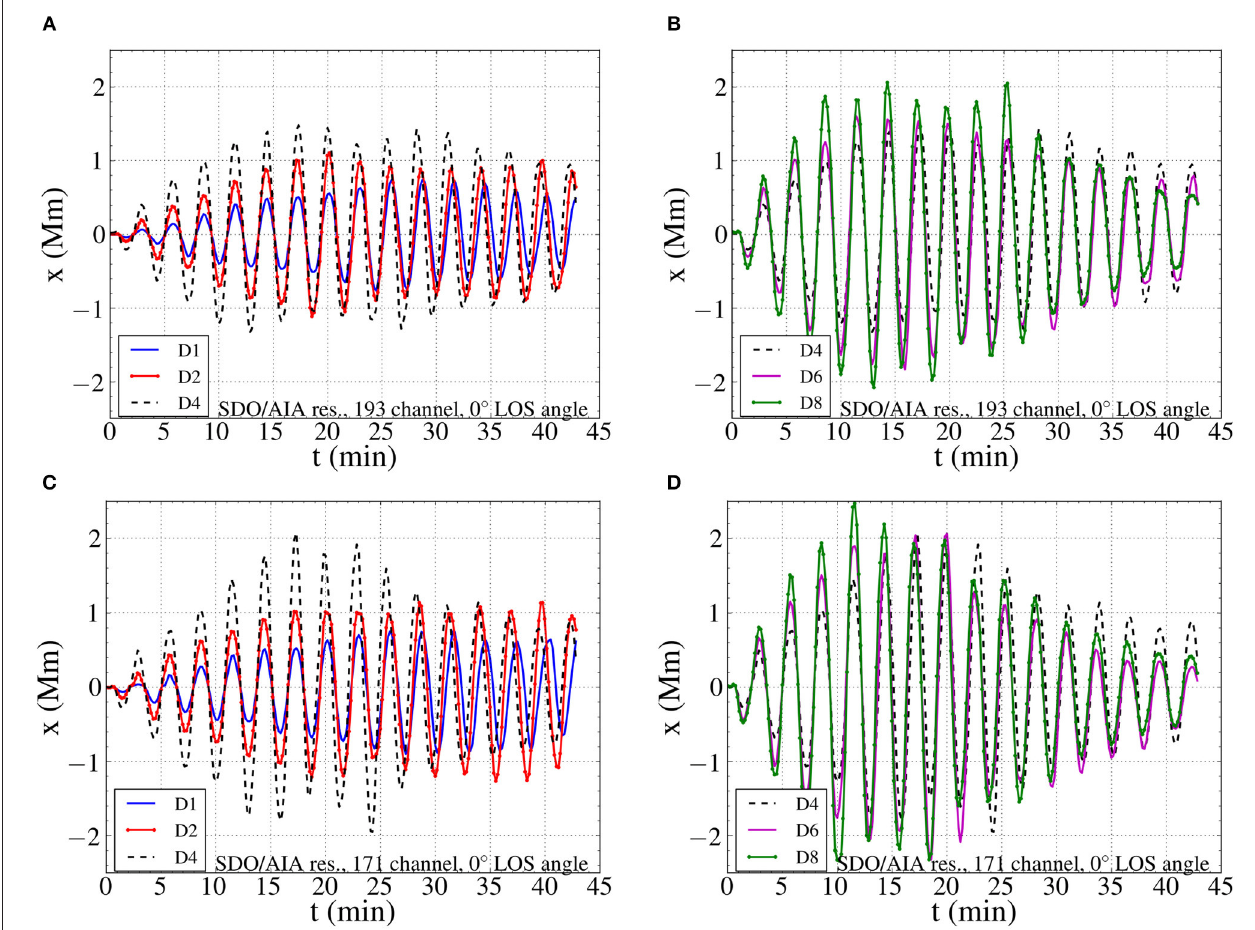
FIGURE 4 | Time distance maps of the oscillation amplitude for the five models. The apex displacements were obtained by tracking the loop edge in synthetic emission images of the Fe XII 193 Åline for (A,B) and of the Fe IX 171 Åline for (C,D) , at 0 ◦